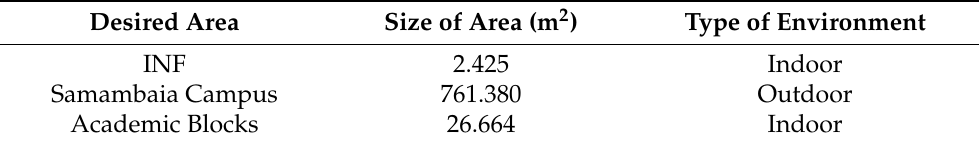
Table 1. The measurements of the areas that were used in the use